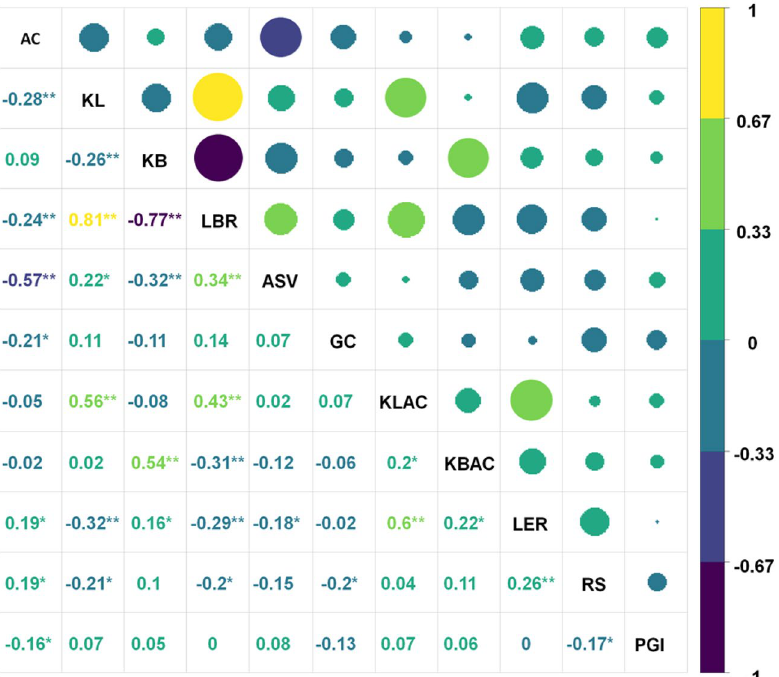
Figure 2. Investigation on correlation coefficients explaining associations among predicted glycemic index and resistant starch with rice quality parameters under transplanted rice system. AC—Amylose content, KL—Kernel length, KB—Kernel breadth, LBR—Length/ Breadth ratio, ASV—Alkali spreading value, KLAC—Kernel length after cooking, KBAC—Kernel breadth after cooking, LER—Linear elongation ratio, GC—Gel consistency, RS— Resistant starch, PGI—Predicted glycemic index, TPR—Transplanted rice. * Significance at p -value < 0.05, ** Significance at p -value <